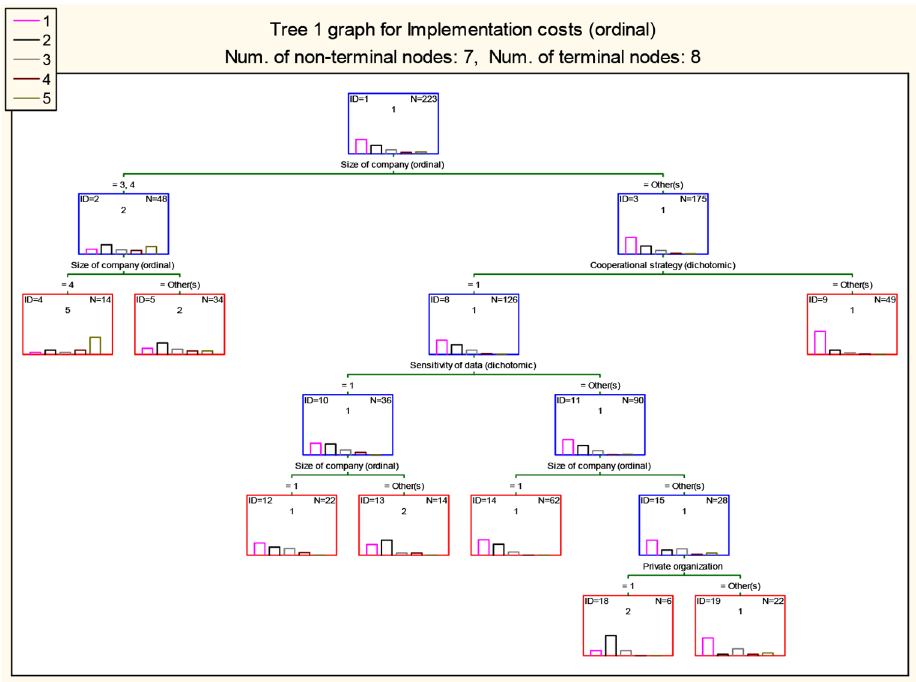
Figure 1. Correlation and regression tree